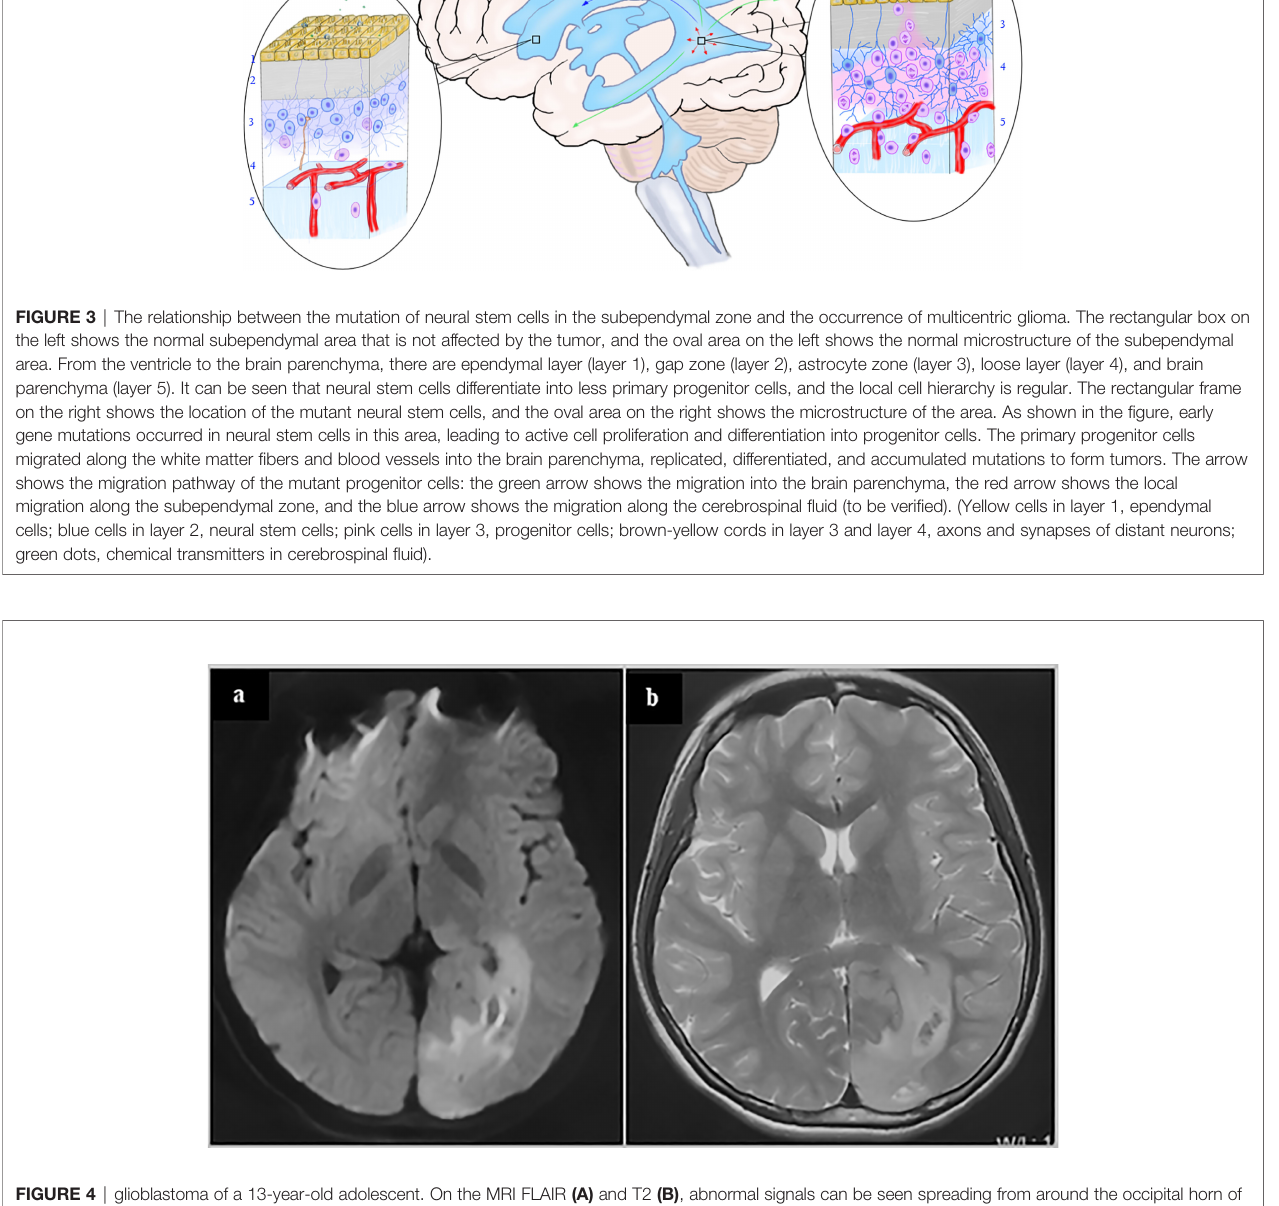
FIGURE 4 | glioblastoma of a 13-year-old adolescent. On the MRI FLAIR (A) and T2 (B) , abnormal signals can be seen spreading from around the occipital horn of the ventricle to the occipital cortex. These abnormal signals may re fl ect the process of the migration, replication and differentiation of the mutant precursor cells from the subependymal zone to the mature brain lobe. The patient underwent a subtotal tumor resection. Postoperative pathology revealed GBM. Immunohistochemistry showed Ki67 20%+, IDH1-, TP53 weakly+, Olig2-, H3K27M-, H3K27me3+, and ATRX partially missing. The patient was given local radiation and temozolomide based chemotherapy after surgery and is currently under follow-up (3 months after